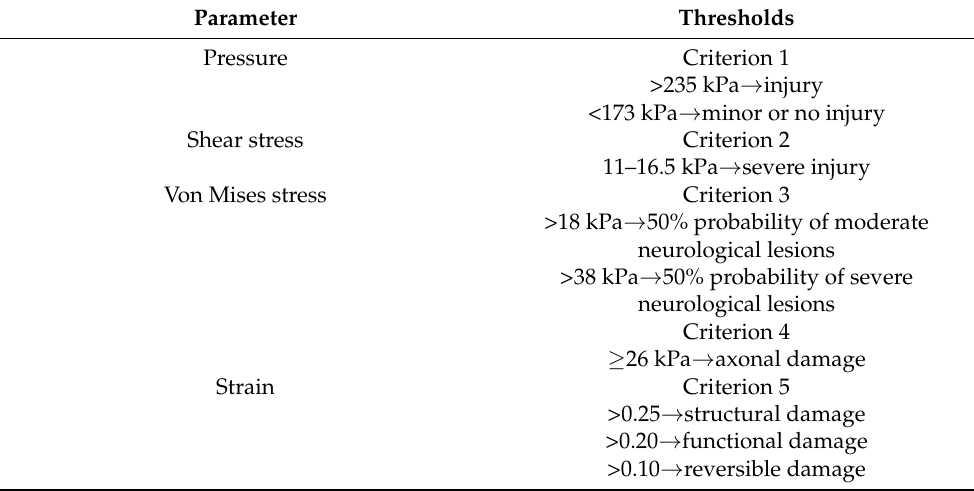
Table 3. Threshold of brain injury criteria